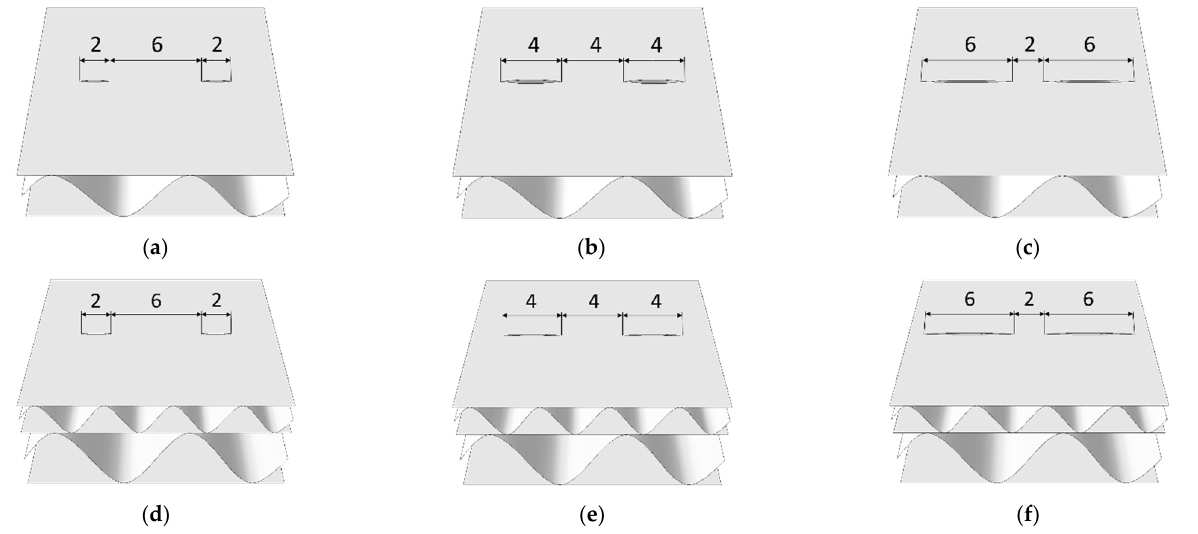
Figure 3. Perforation types: ( a ) Type 2/6—model SW; ( b ) Type 4/4—model SW; ( c ) Type 6/2—model SW; ( d ) Type 2/6—model DW; ( e ) Type 4/4—model DW; ( f ) Type 6/2—model DW.